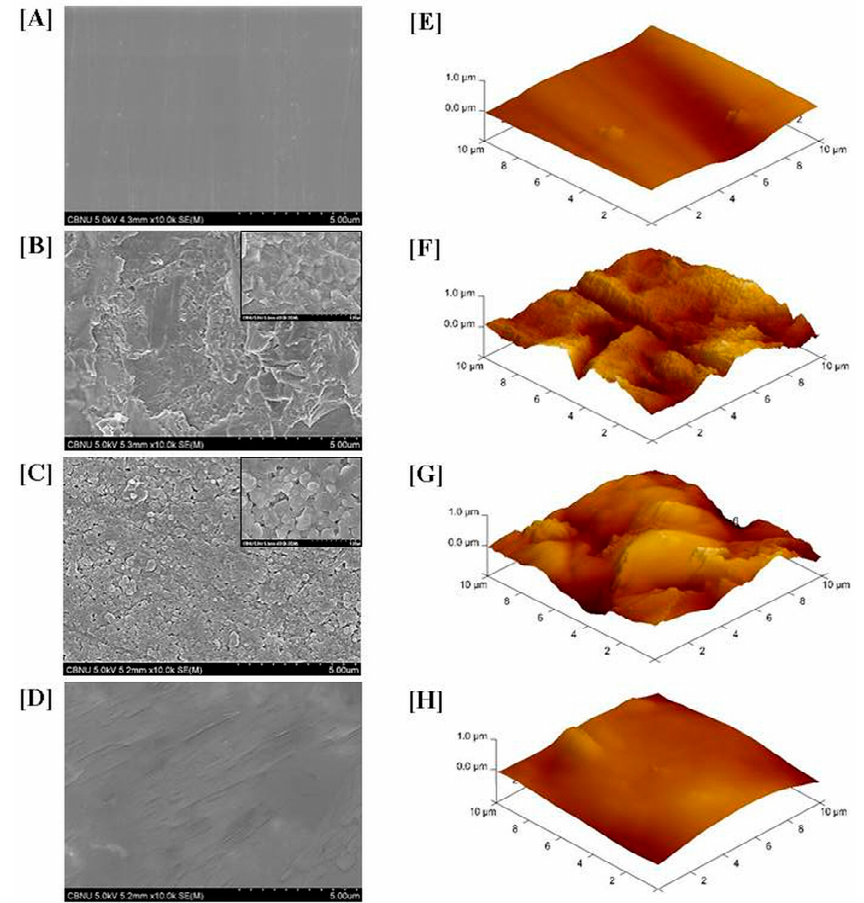
Figure 4. FE-SEM images (magnifications: × 10,000, × 50,000) and AFM images (spot size: 10 µ m × 10 µ m). ( A , E ) Polishing; ( B , F ) Sandblasting; ( C , G ) Sandblasting + SIE technique; ( D , H ) Sandblasting + MDP-containing silane primer.